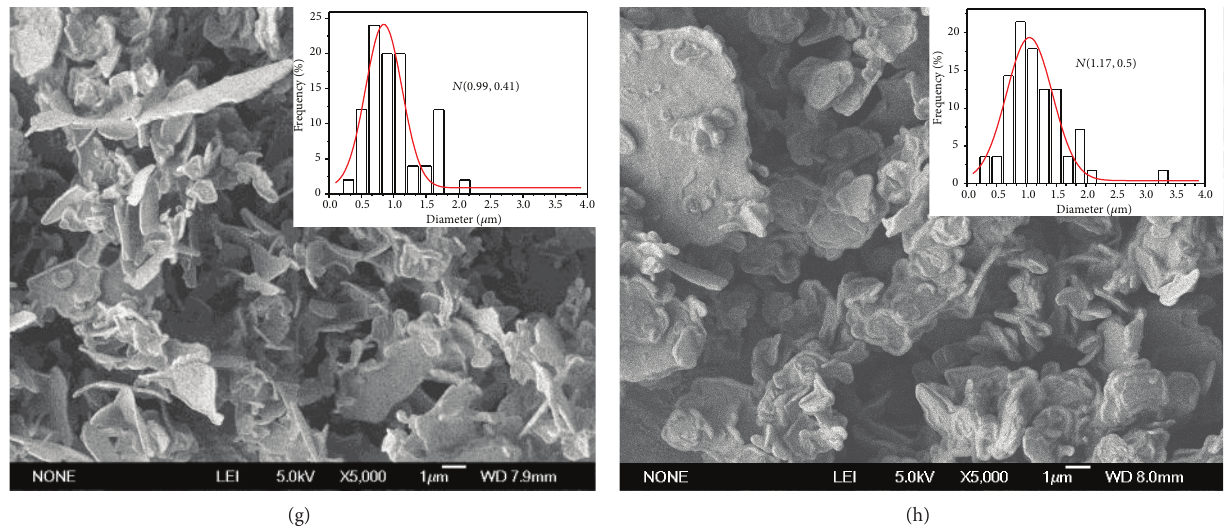
Figure 2: SEM micrographs of stearic acid particles collected at different conditions: (a) 15MPa, 333 K; (b) 15MPa, 348 K; (c) 20MPa, 333 K; (d) 20MPa, 348 K; (e) 30MPa, 333 K; (f) 30MPa, 348K; (g) 35MPa, 333 K; (h) 35 MPa, 348